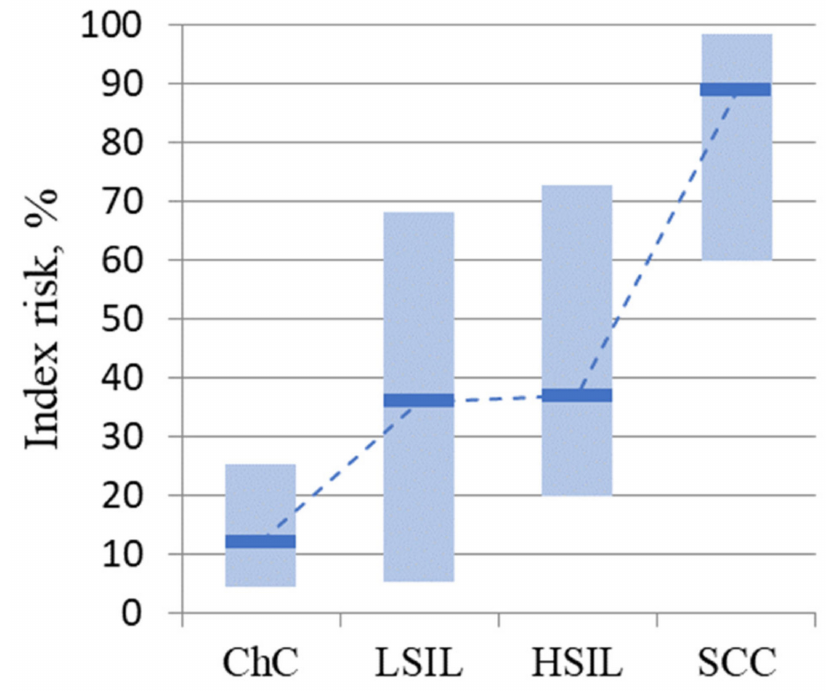
Figure 2. Risk index values for disease progression by group. The medians in the study groups and the interquartile range are